Question: Provide a one-line summary of what is displayed.
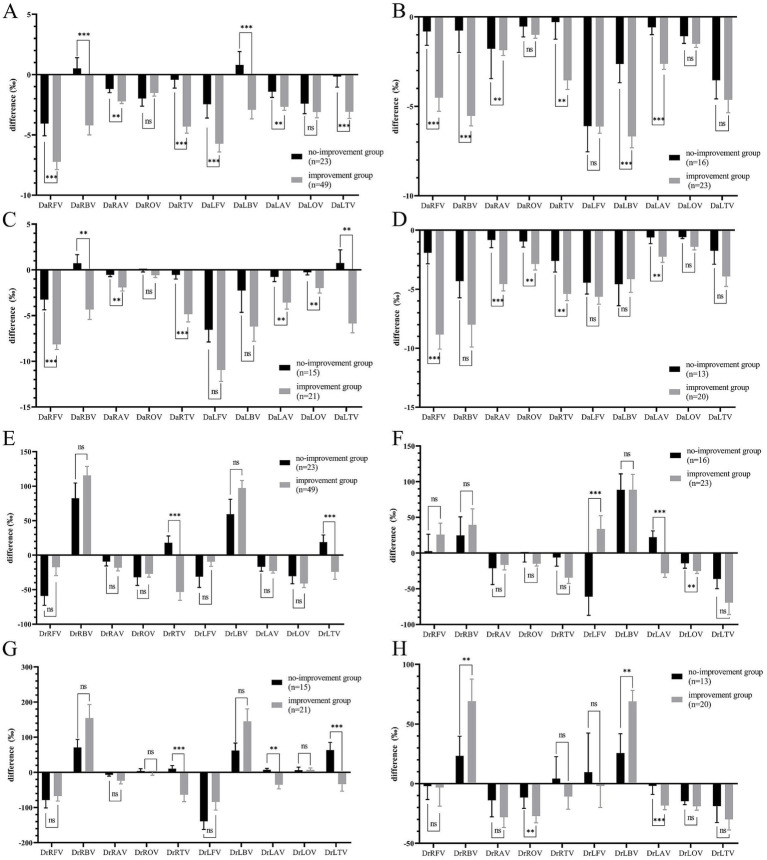
Answer: The relationship between the early clinical symptom improvement and differences in ventricular volume of the lateral ventricle subregions before and after VPS in HANPH. It shows that the early clinical improvement is associated with differences in the absolute ventricular volume of the lateral ventricle subregions in HANPH (non-DC, RSC) (A) , HANPH (non-DC, LSC) (B) , HANPH (DC, RSC) (C) , and HANPH (DC, LSC) (D) . Additionally, there is a relationship with differences in the relative ventricular volume of subregions in HANPH (non-DC, RSC) (E) , HANPH (non-DC, LSC) (F) , HANPH (DC, RSC) (G) , and HANPH (DC, LSC) (H) . ns: p ≥ 0.05, * p < 0.05, ** p < 0.01 and *** p < 0.001.